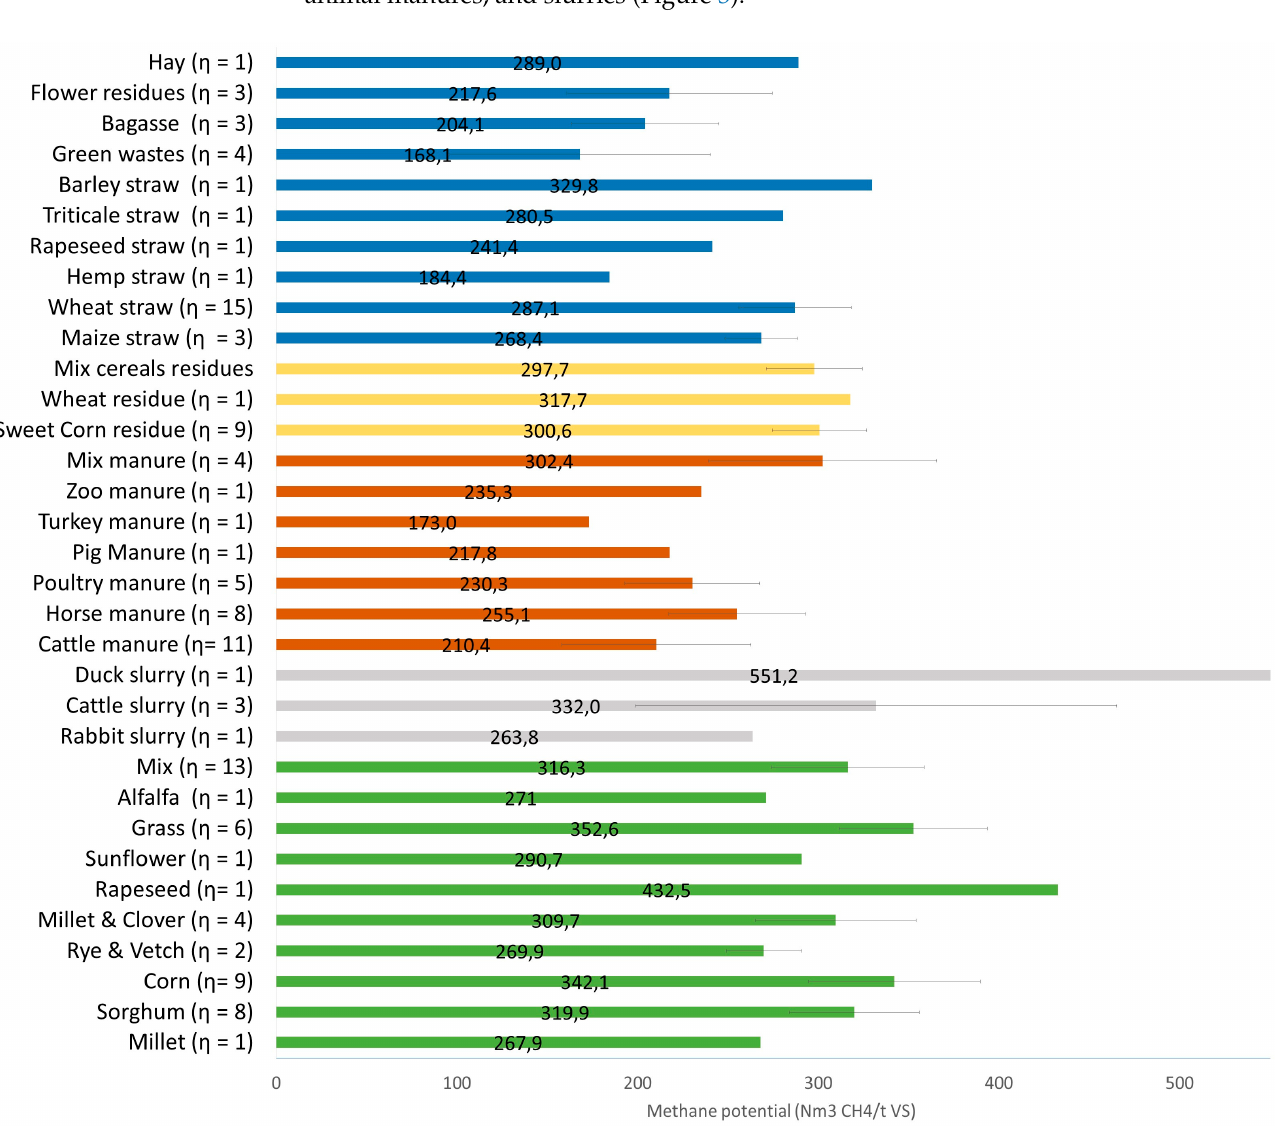
Figure 3. Methane potentials of the different categories of the five families. Families: cereal and agro-industrial residue in grey (CER), energy crop and silage in blue (ENSI), lignocellulosic matter in green (LCM), manure in red (MAN), and slurry in yellow (SLU).